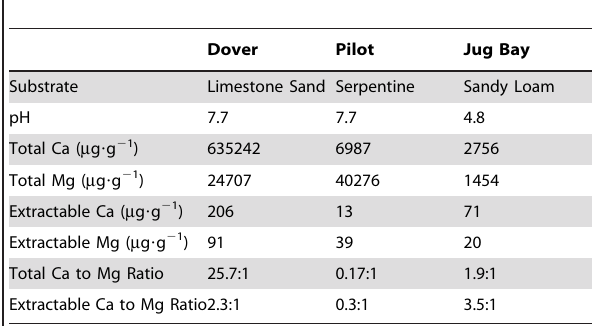
Table 1. Soil characteristics for Dover, Pilot and Jug Bay populations of A. l. ssp. lyrata